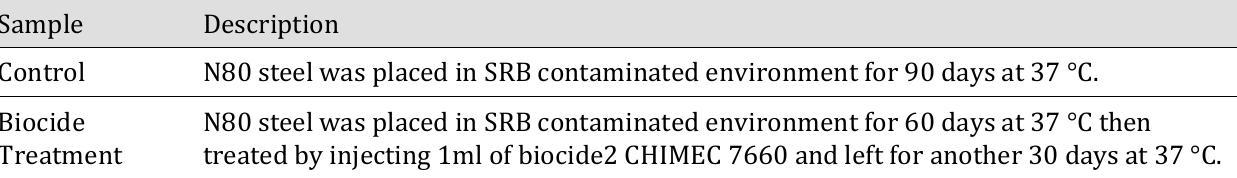
Meter Table 3. Description of the